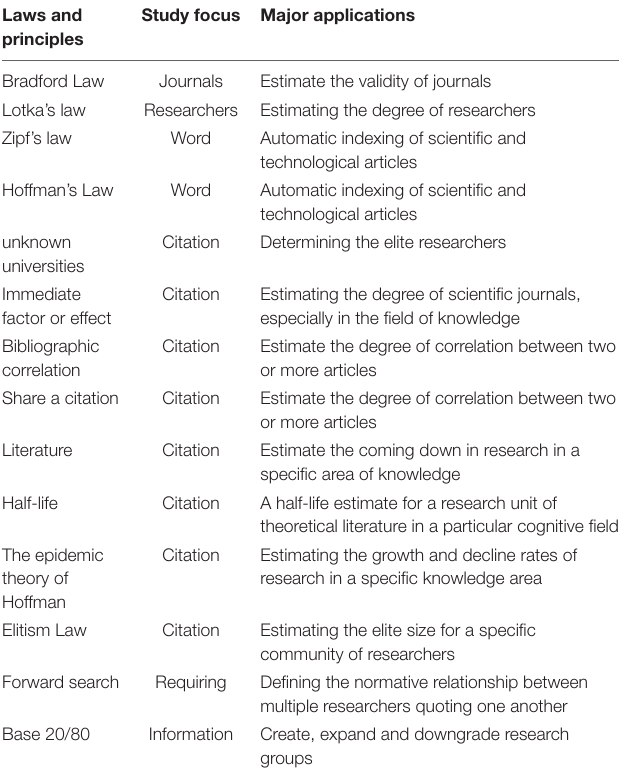
TABLE 1 | Fundamental laws of bibliometric